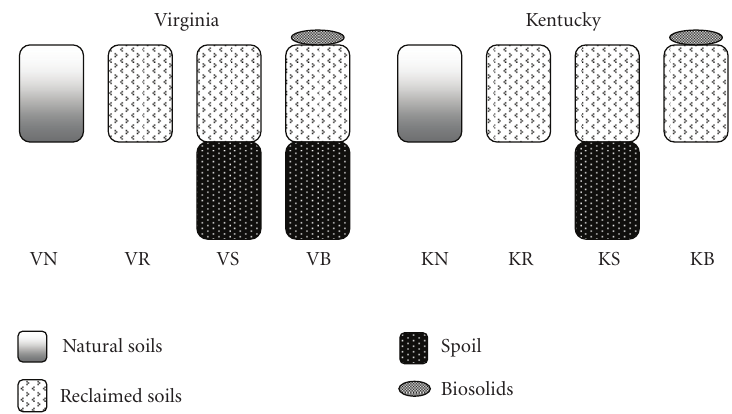
Figure 1: Diagram of the soil monoliths for the Virginia and Kentucky